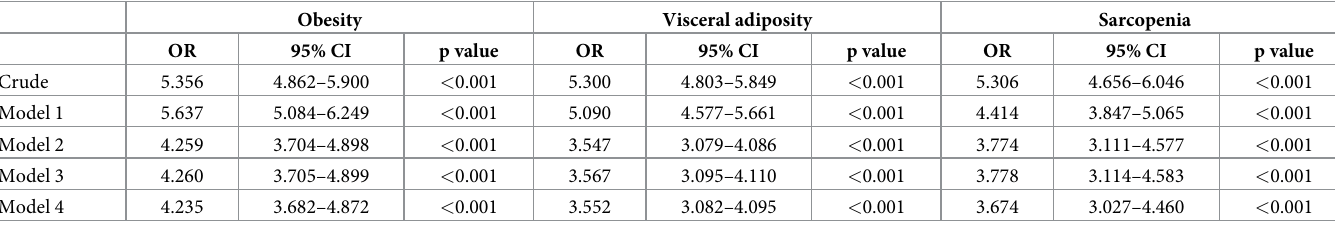
Table 5. Odds ratios of metabolic syndrome according to the presence of obesity, visceral adiposity, and sarcopenia. Obesity Visceral adiposity Sarcopenia OR 95% CI p value OR 95% CI p value OR 95% CI p value Crude